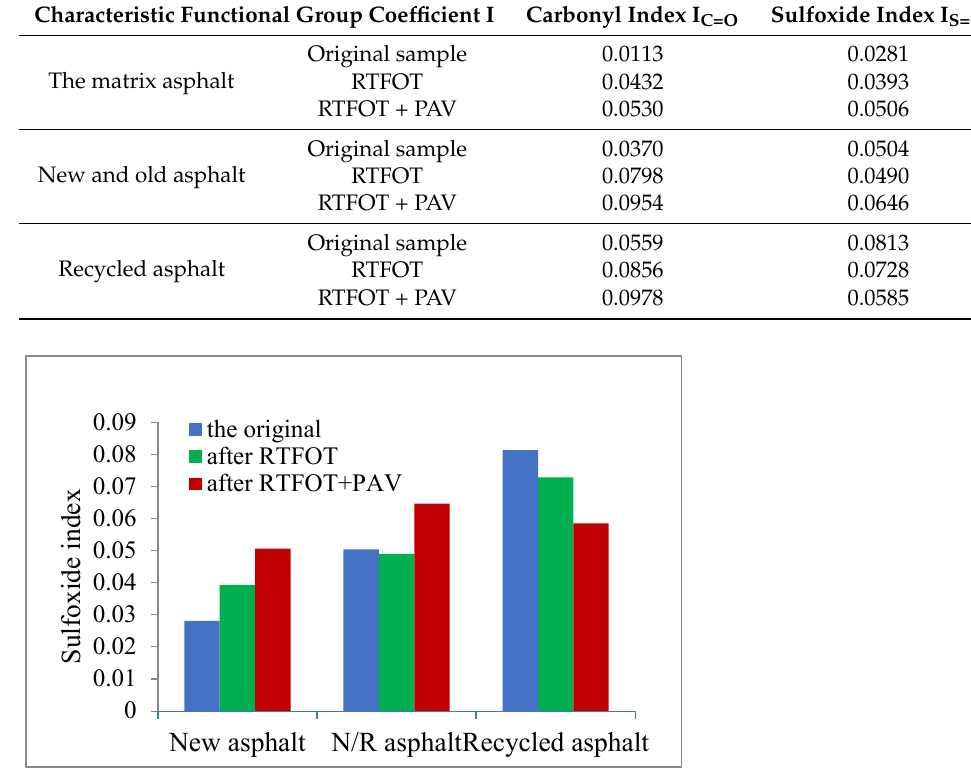
Figure 5. Sulfoxide index of the three asphalts before and after aging.